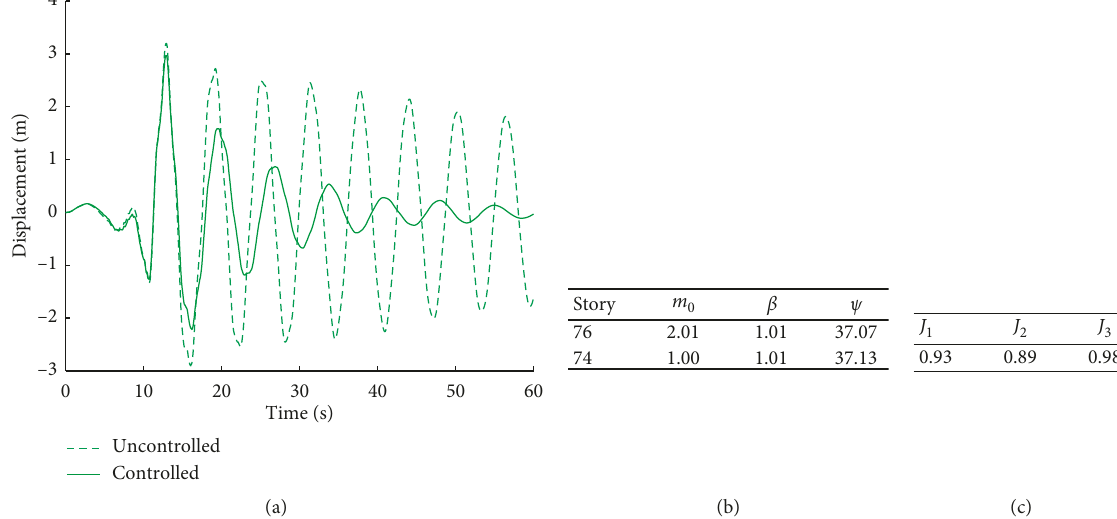
Figure 14: Uncontrolled/controlled responses under the Landers earthquake. (a) Roof displacement response. (b) TMD specifications. (c) Objective values.